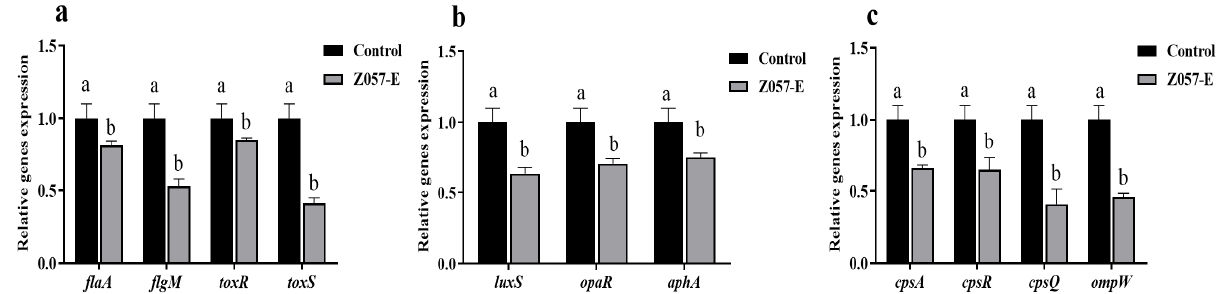
Figure 8. The effects of Z057-E on the expression levels of V. parahaemolyticus biofilm-related genes and QS-related genes. ( a ) Flagellum synthesis and hemolysin secretion-related genes. ( b ) QS-related genes. ( c ) EPS and extracellular protein synthesis-related genes. Significant differences ( p < 0.05) are indicated by different letters (a and b).